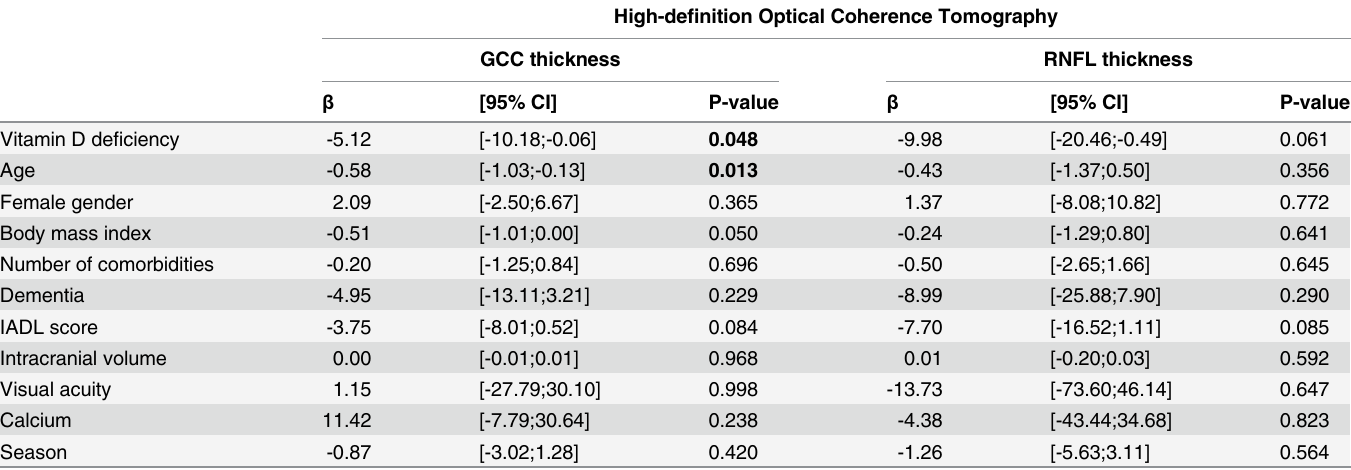
Table 3 reports the correlations between vitamin D deficiency and the thickness of the dif- ferent sectors of the GCC and the RNFL. Vitamin D deficiency correlated negatively with the mean superior medial GCC (r = -0.26, P = 0.017) and superior temporal GCC (r = -0.28, P = 0.010), and there was a trend for a correlation with the superior nasal GCC (r = -0.21, Table 2. Fully adjusted linear regressions examining the association between vitamin D deficiency * (explanatory variable) and the GCC and RNFL thickness † (dependent quantitative variables), adjusted for potential confounders (n = 85). High-de fi nition Optical Coherence Tomography GCC